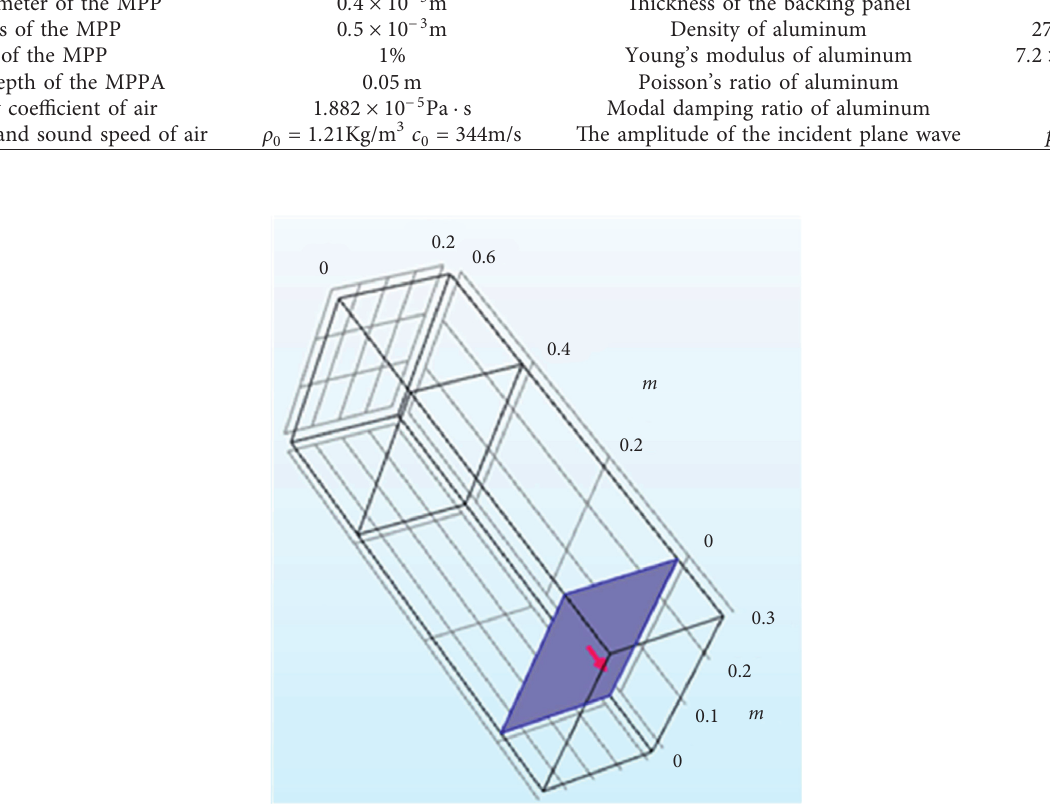
Figure 2: The schematic diagram of the finite element model.